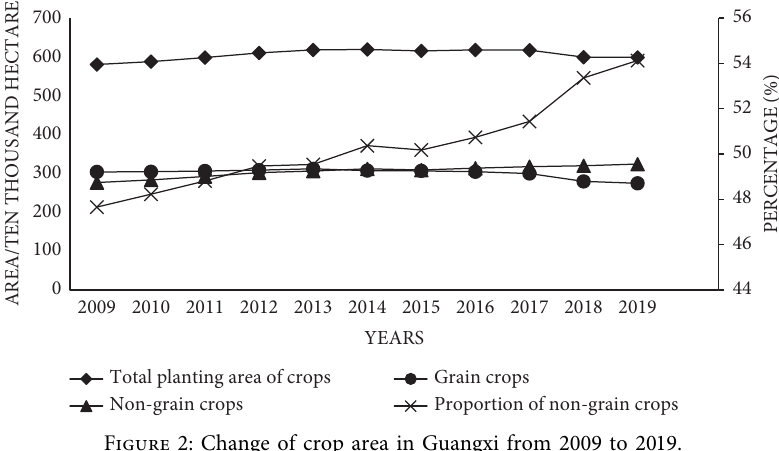
Figure 2: Change of crop area in Guangxi from 2009 to 2019.